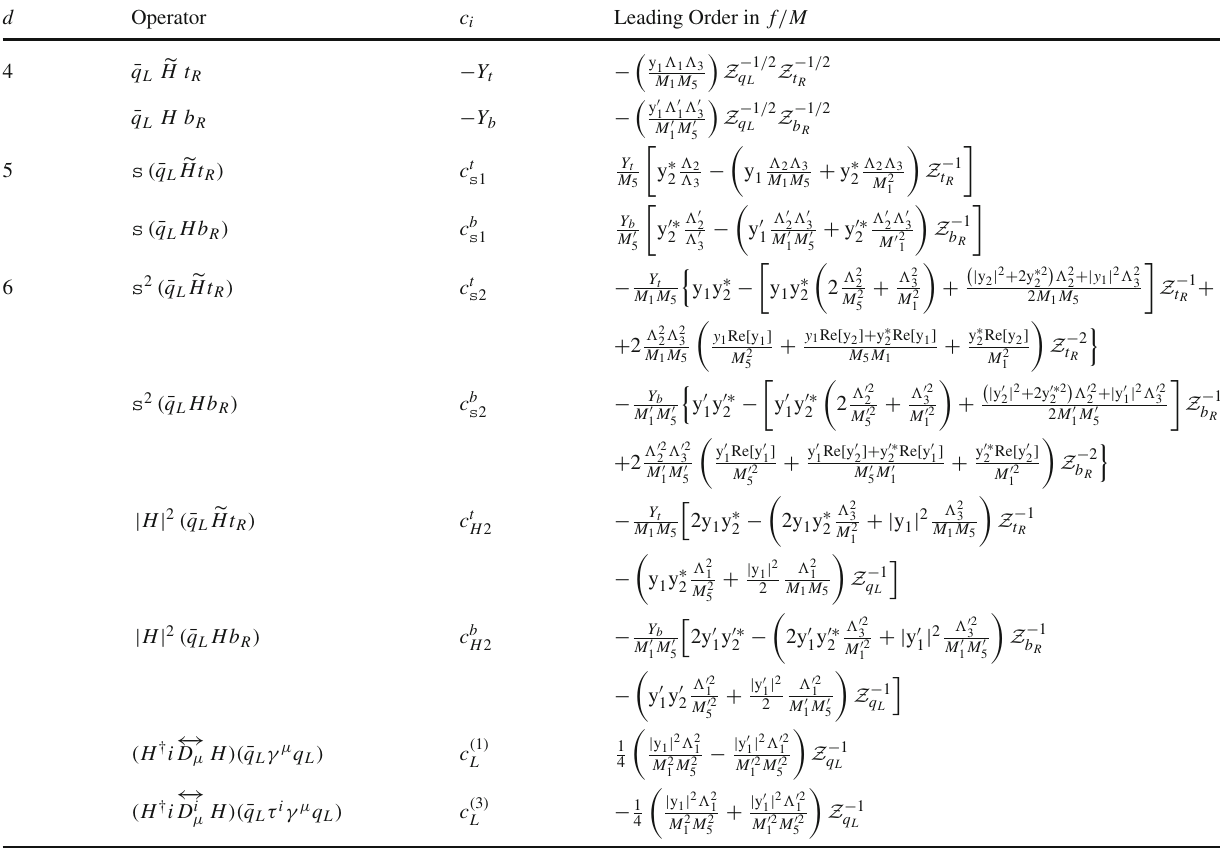
Table 3 Leading order effective operators and their coefficients. The wave function renormalisation factors have been defined in Eq. (2.31) d Operator c i Leading Order in f /